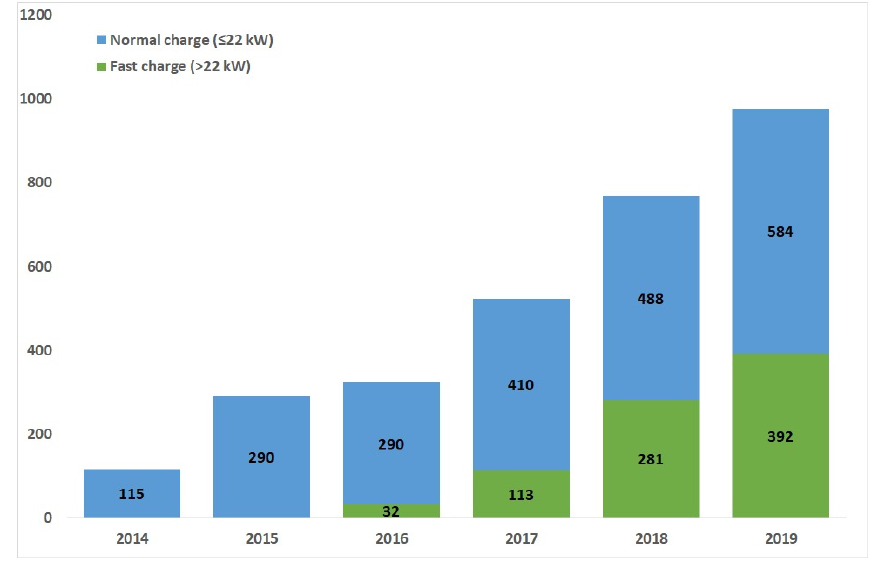
Figure 3. Development of infrastructure of electric car charging points in Poland [31] .